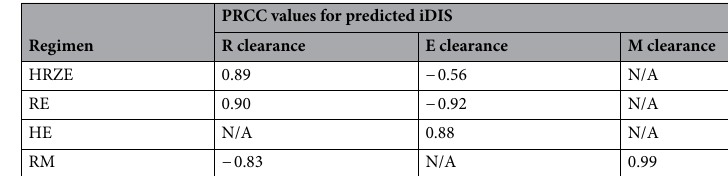
Table 1. Significant antibiotic clearance rate constants in determining iDIS. The relationship between clearance rate constants for different antibiotics is correlated with iDIS with non-replicating Mtb during the first dose of therapy. Table shows PRCC values relating the clearance rate constants to the predicted iDIS for the regimens HRZE, RE, HE and RM. The values shown represent PRCC values that are significant with p <